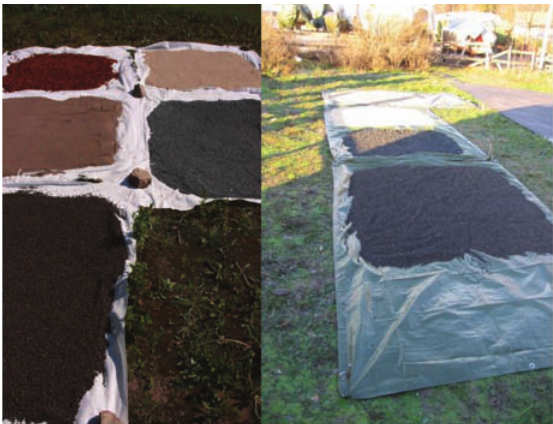
Fig. 3 . Gravel setup in Nuuksio, Jul. 2007. Clockwise from top left: crushed redbrick (C Brick), sandblasting sand (Sand01), black gabbro (Gabbro), crushed LECA (LECA), and sandblasting sand (Sand05). Right: gravel samples in Espoonlahti, Dec. 2007 campaign, from top downward: Gravel, Qartz, Diabase and LECA (Kaasalainen et al . 2008b)